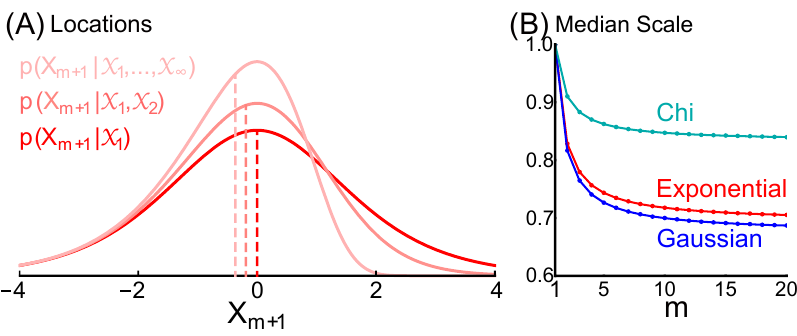
Figure 3. A known number is not the median if there is additional information about location or scale. We illustrate the special case that there are m knowns, all equal to one another. ( A ) The density over locations p ( X m + 1 | X 1 = . . . , X m = 0 ) for m of 1,2, and ∞ , given the exponential dependence. Vertical lines indicate medians. We show distributions over location rather than scale so that the asymmetry is easily seen. ( B ) The median scale x 1 = e X 1 decreases as m increases, for exponential (red), Gaussian (blue), and chi (cyan)